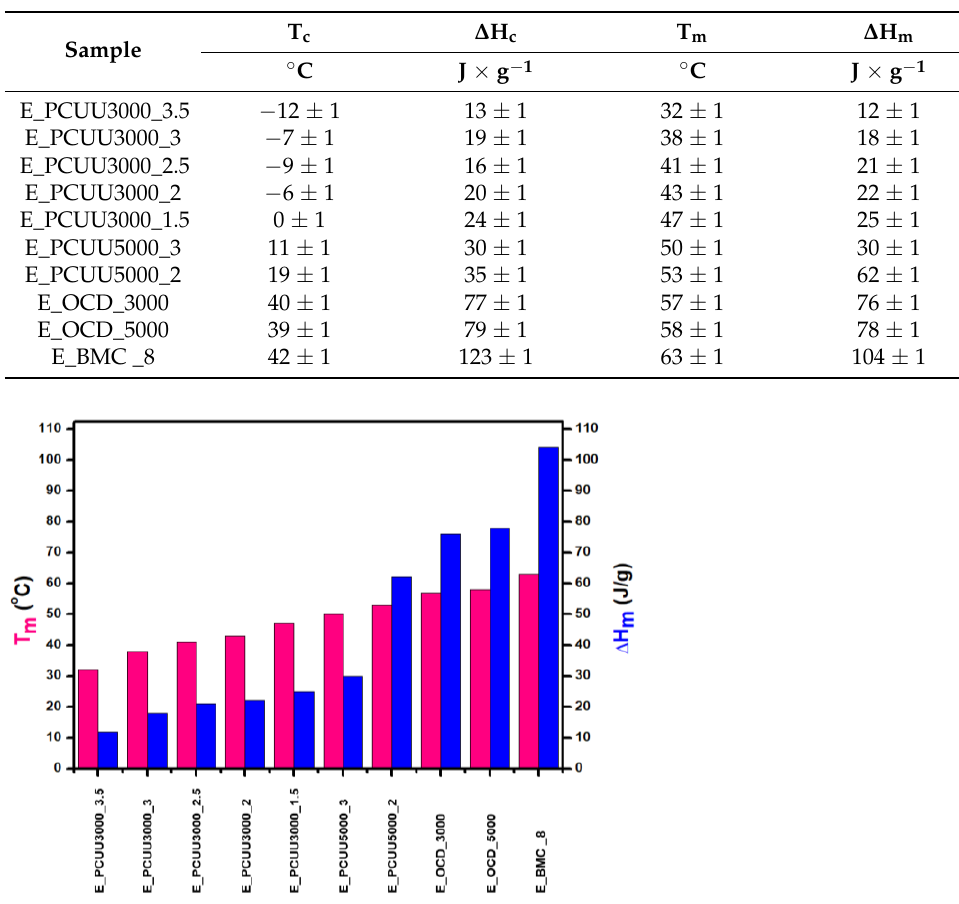
Table 3. Thermal properties determined based on DSC measurements of PCUUs, OCDs, and BMC.